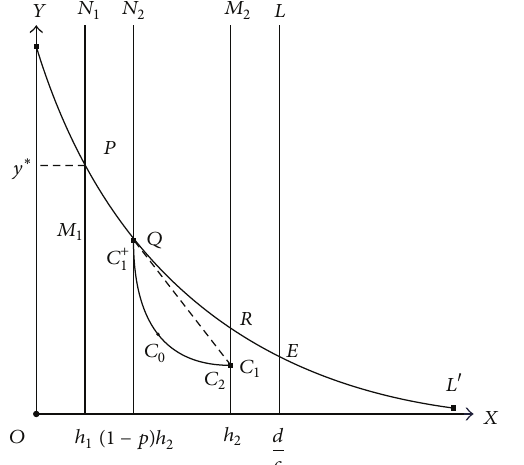
Figure 10: The orbit starting from the point 𝐶 0 (Case 1(a) in Section 4.1.3).